Question: Identify the chart type used in this figure.
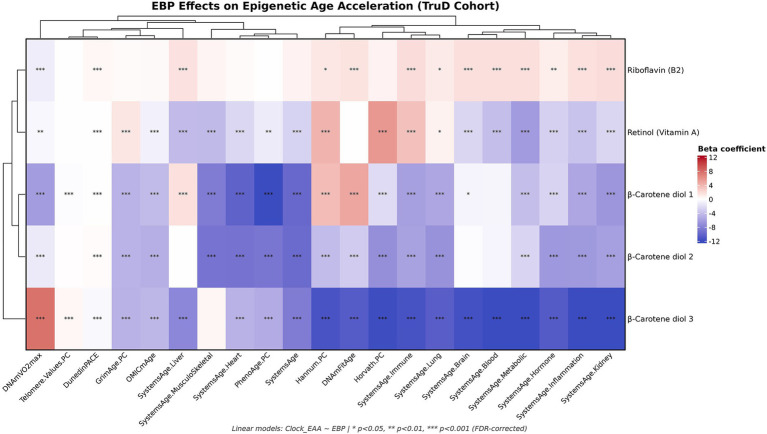
Answer: heatmap